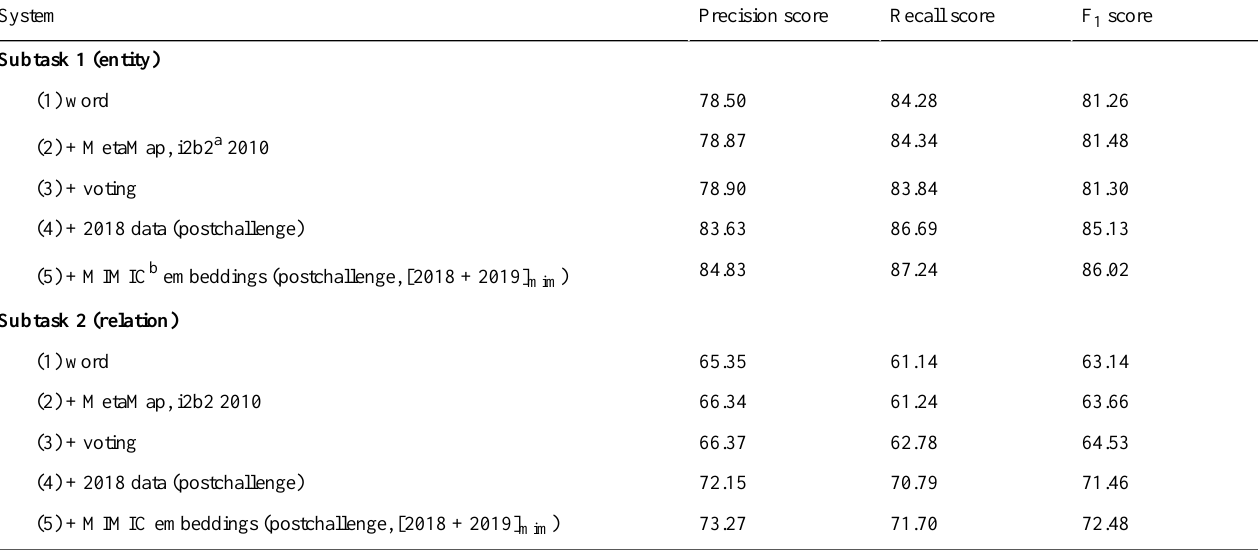
Table 4. Improved performance by feature or data